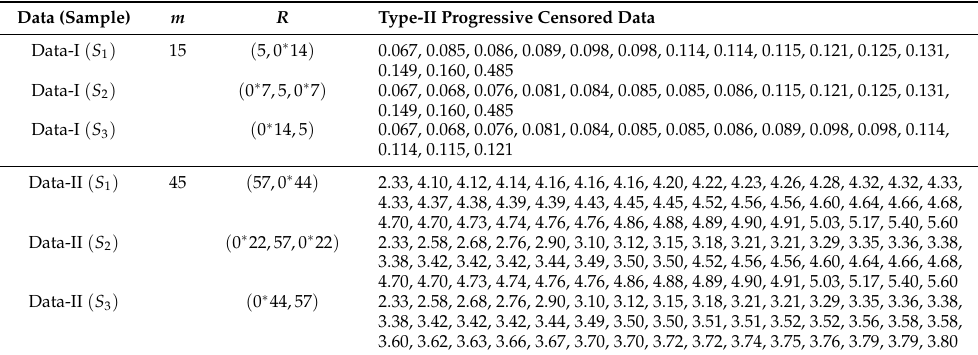
Table 4. Various Type-II progressively censored samples from mechanical components and metal-coupons data